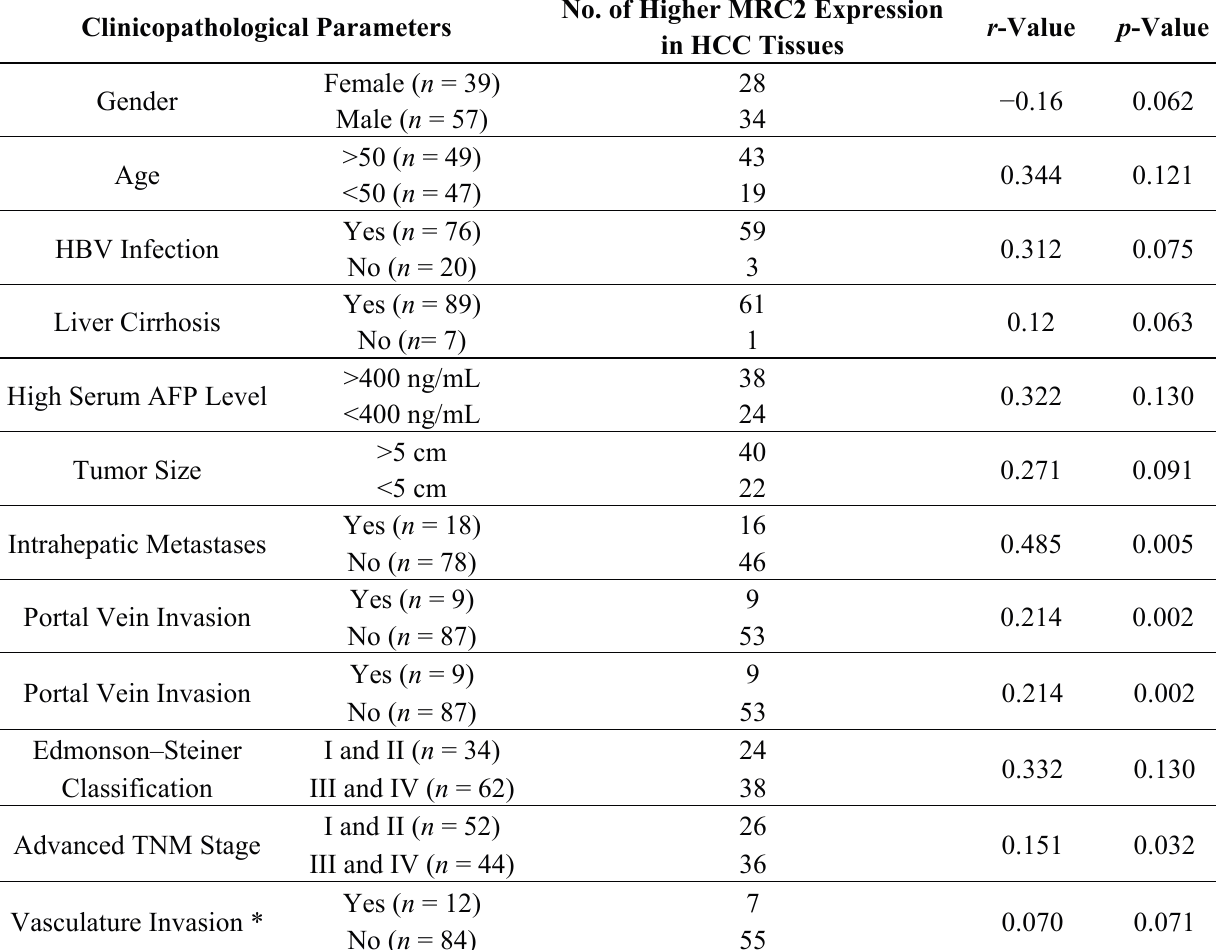
Table 1. Correlation between the Clinicopathological Parameters and Mannose Receptor C Type 2 (MRC2) Expression in 96